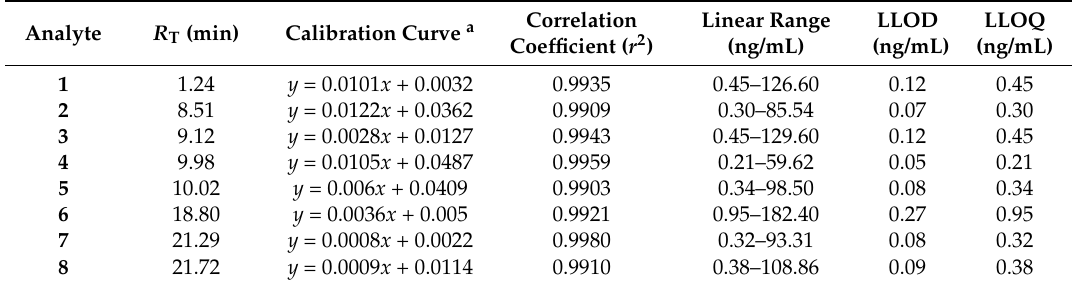
Table 1. Calibration curves, LLODs, and LLOQs for eight